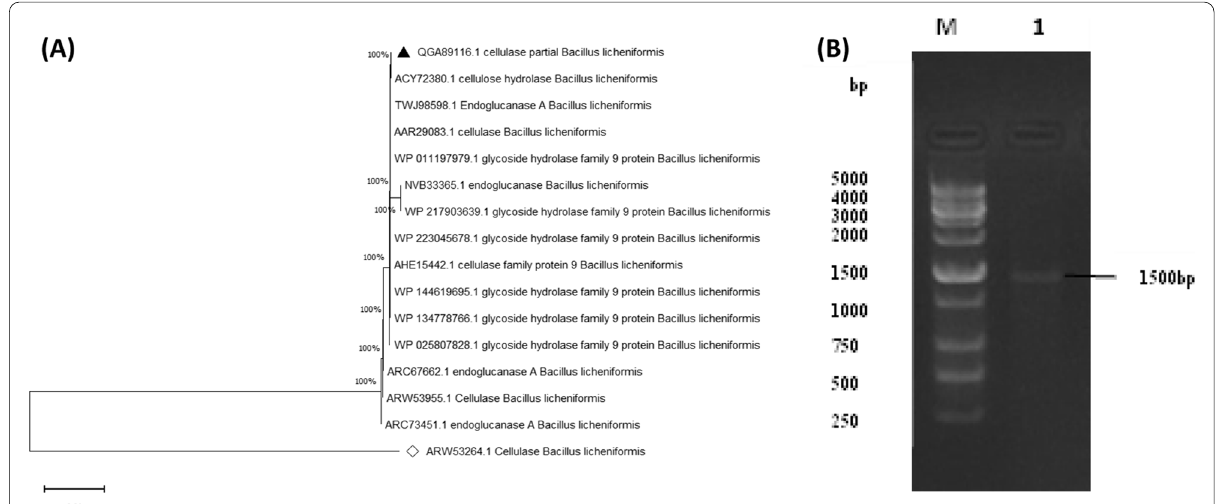
Fig. 1 A Phylogenetic relationships of Bacillus licheniformis cel9z gene. The phylogenetic tree was drawn based on the neighbor joining method with Kimura 2 parameter distances using the MEGA 11 software. The values at the nodes represent the percentages of 1000 bootstrap replicates. Bar, 0.2 substitutions per nucleotide position. B Amplification of B. licheniformis Z9 cellulase gene. Lane M: SiZer‑10 kb DNA ladder (iNtRON